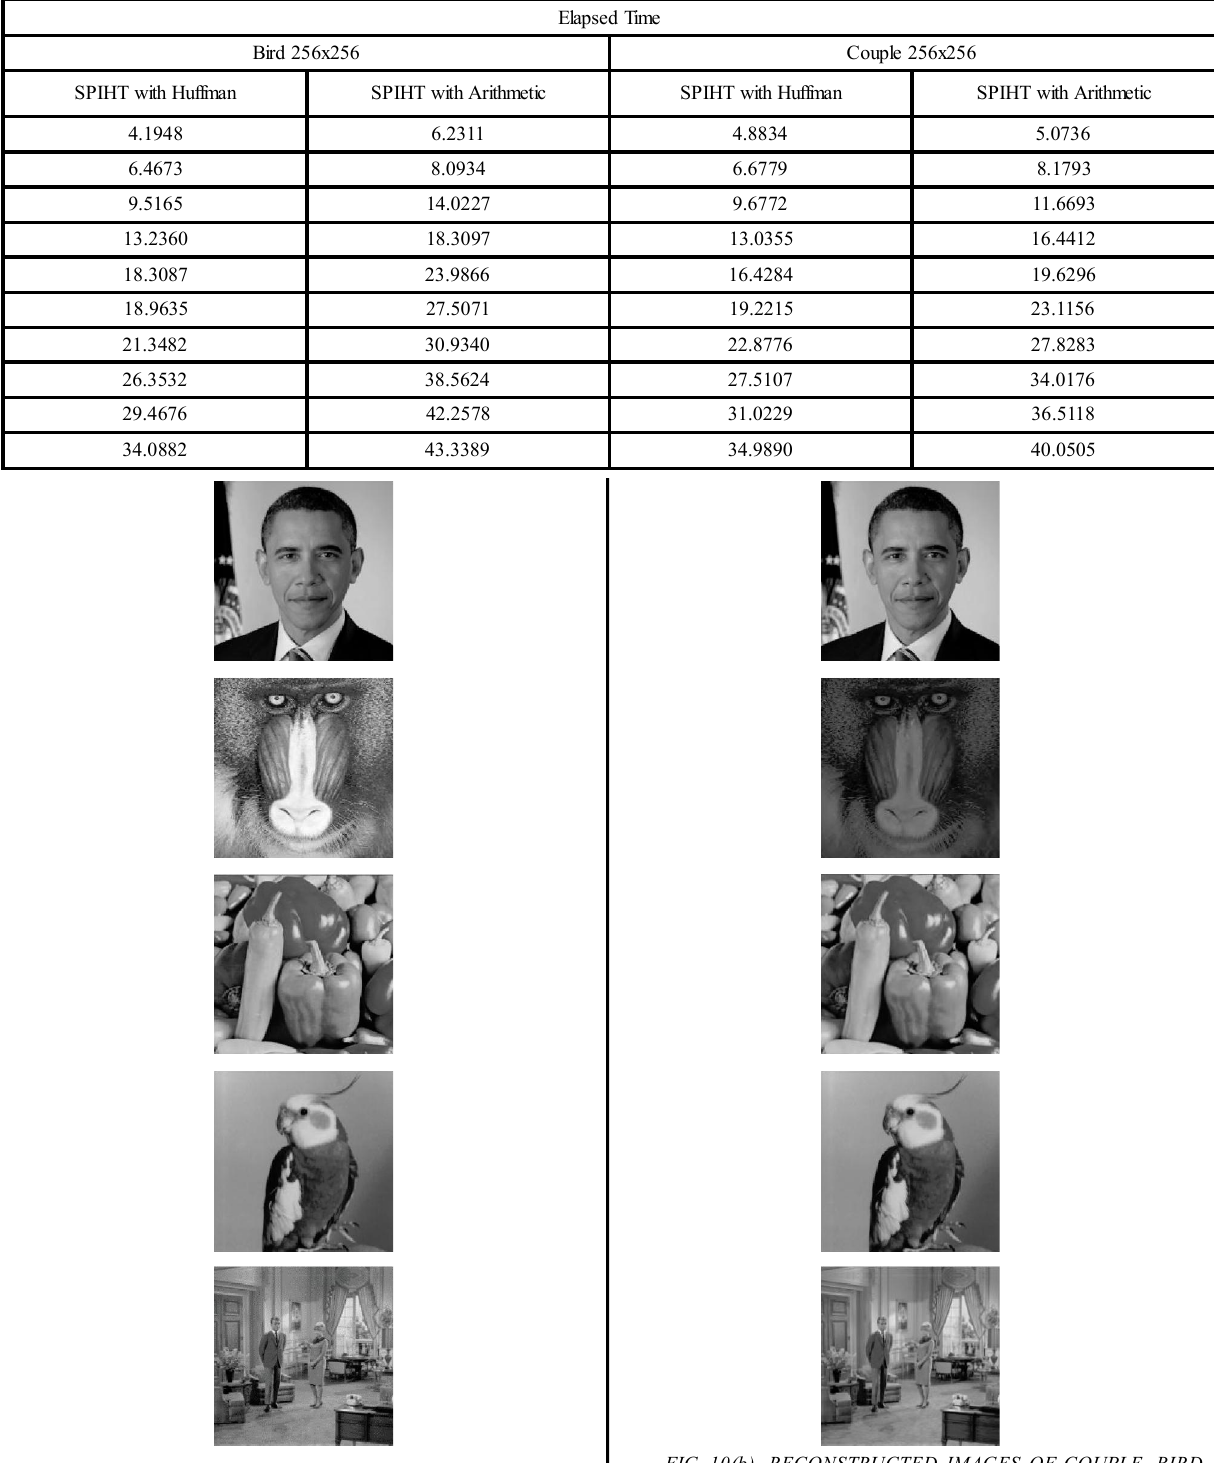
FIG. 10(b). RECONSTRUCTED IMAGES OF COUPLE, BIRD, OBAMA, PEPPER AND